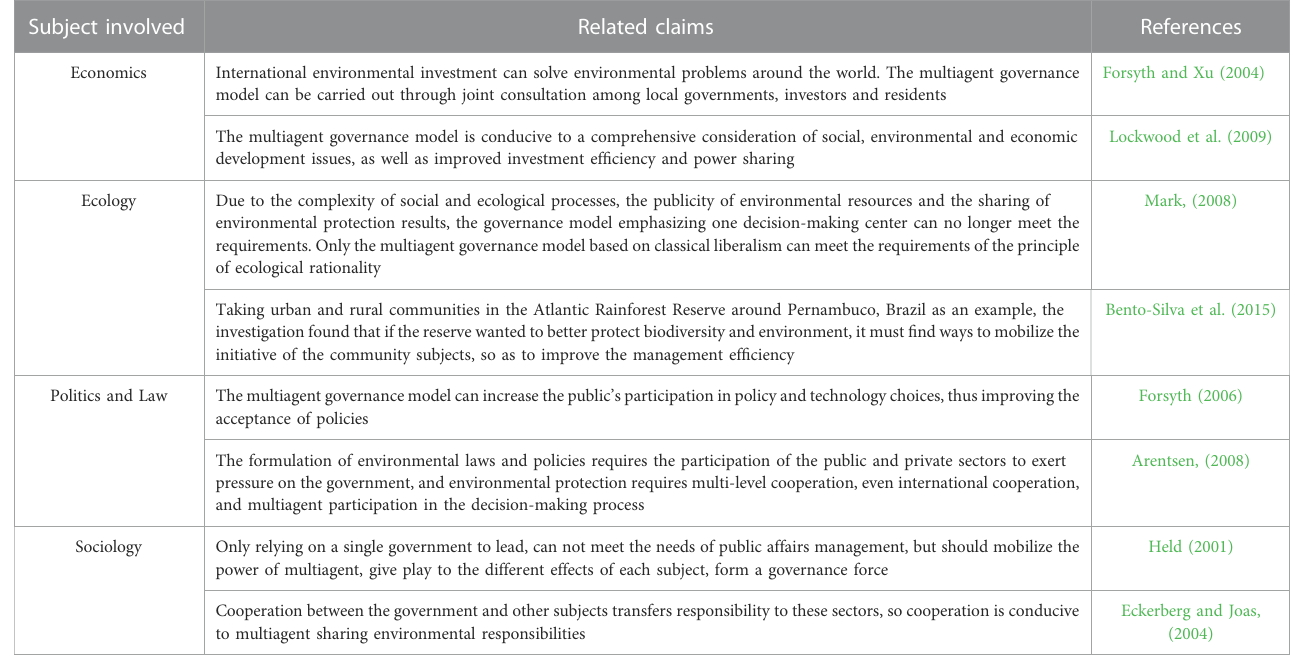
TABLE 1 The propositions of various disciplines on multiagent